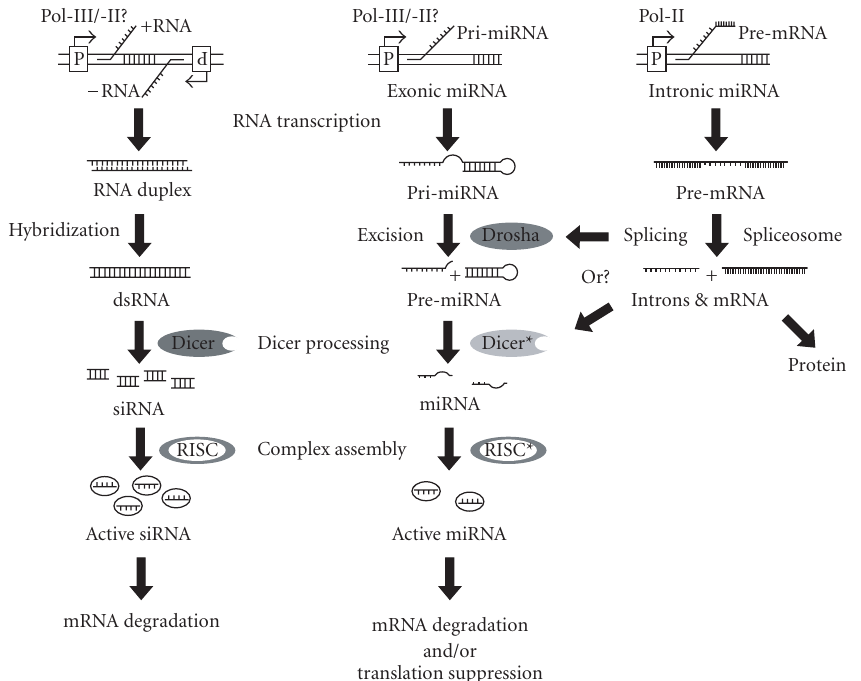
Figure 1: Comparison of biogenesis and RNAi mechanisms among siRNA, intergenic (exonic) miRNA, and intronic miRNA. siRNA is likely formed by two perfectly complementary RNAs transcribed from two di ff erent promoters (remaining to be determined) and further processing into 19–22 bp duplexes by the RNase III-familial endonuclease, Dicer. The biogenesis of intergenic miRNAs, for example, lin-4 and let-7 , involves a long transcript precursor (pri-miRNA), which is probably generated by Pol-II or Pol-III RNA promoters, while intronic miRNAs are transcribed by the Pol-II promoters of its encoded genes and coexpressed in the intron regions of the gene transcripts (pre- mRNA). After RNA splicing and further processing, the spliced intron may function as a pri-miRNA for intronic miRNA generation. In the nucleus, the pri-miRNA is excised by Drosha RNase to form a hairpin-like pre-miRNA template and then exported to the cytoplasm for further processing by Dicer ∗ to form mature miRNA. The Dicers for siRNA and miRNA pathways are di ff erent. All three small regulatory RNAs are finally incorporated into an RNA-induced silencing complex (RISC), which contains either the strand of siRNA or the single- strand of miRNA. The action of miRNA is considered to be more specific and less adverse than that of siRNA because only one strand is involved. siRNA primarily triggers mRNA degradation, whereas miRNA can induce either mRNA degradation or suppression of protein synthesis depending on the sequence complementarity to the target gene